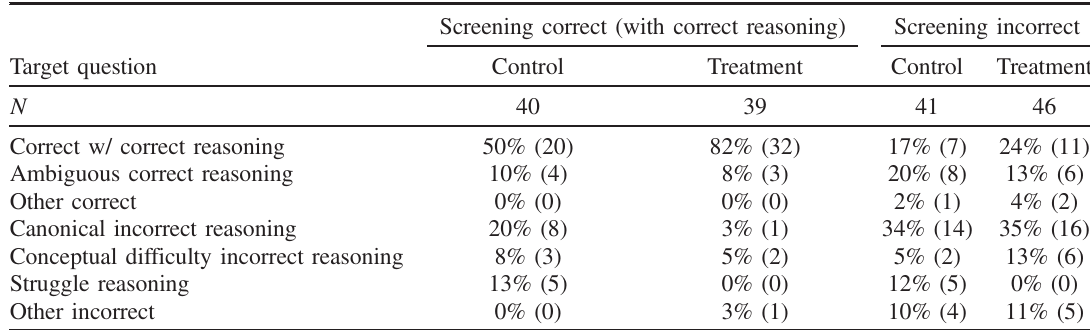
TABLE X. Comparison of reasoning chains in experiment 2B controlling for performance on the screening question shown in Fig. 2(a). Percentages shown represent percentage of students in the respective column. Screening correct (with correct